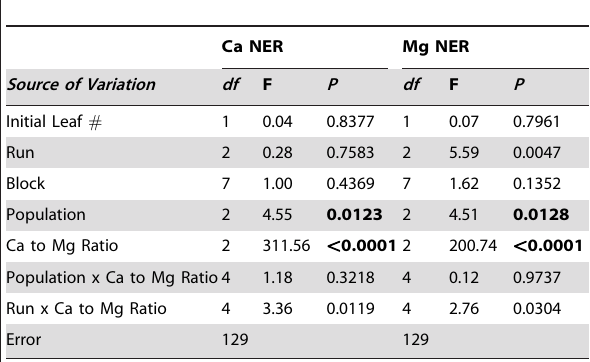
Table 5. ANOVA table for Ca and Mg nutrient efficiency ratio (NER) of three A. l. ssp. lyrata populations exposed to different substrate Ca to Mg